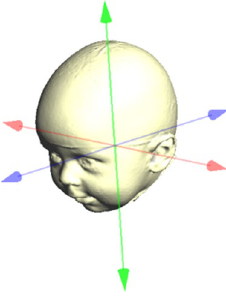
Figure 2. Coordinate system. x-axis: red; y-axis: blue; z-axis: green.